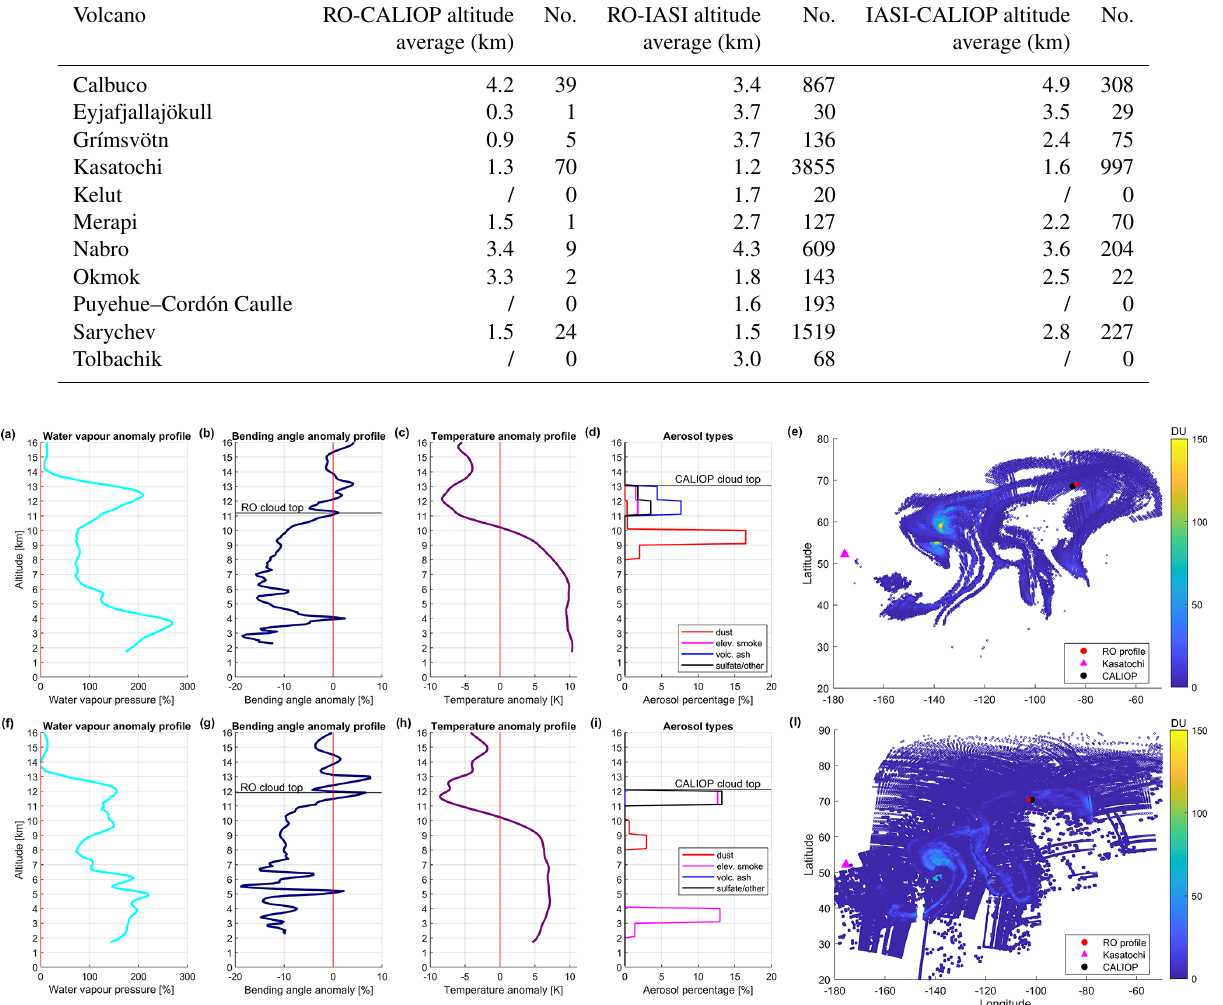
Figure 3. Case study Kastochi 2008. RO profiles corresponding to the CALIOP aerosol type profile collocated with the SO 2 estimation